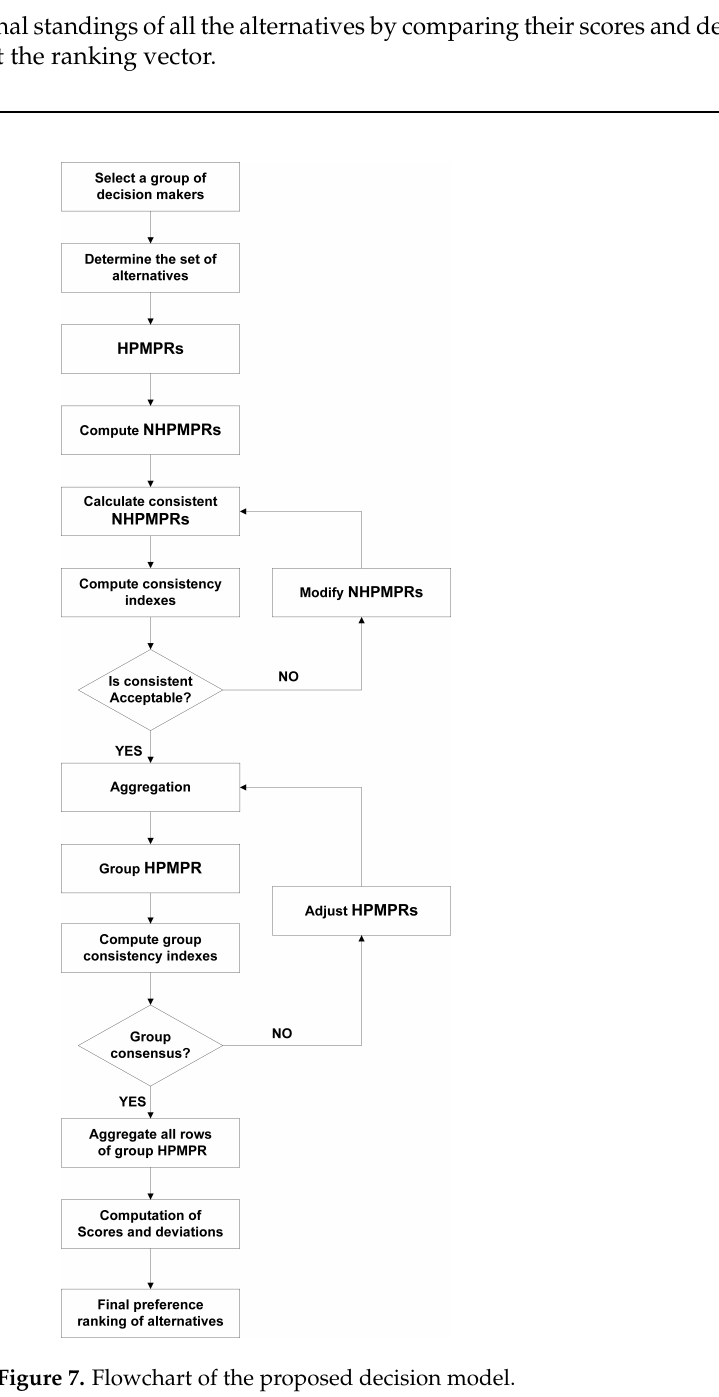
Figure 7. Flowchart of the proposed decision